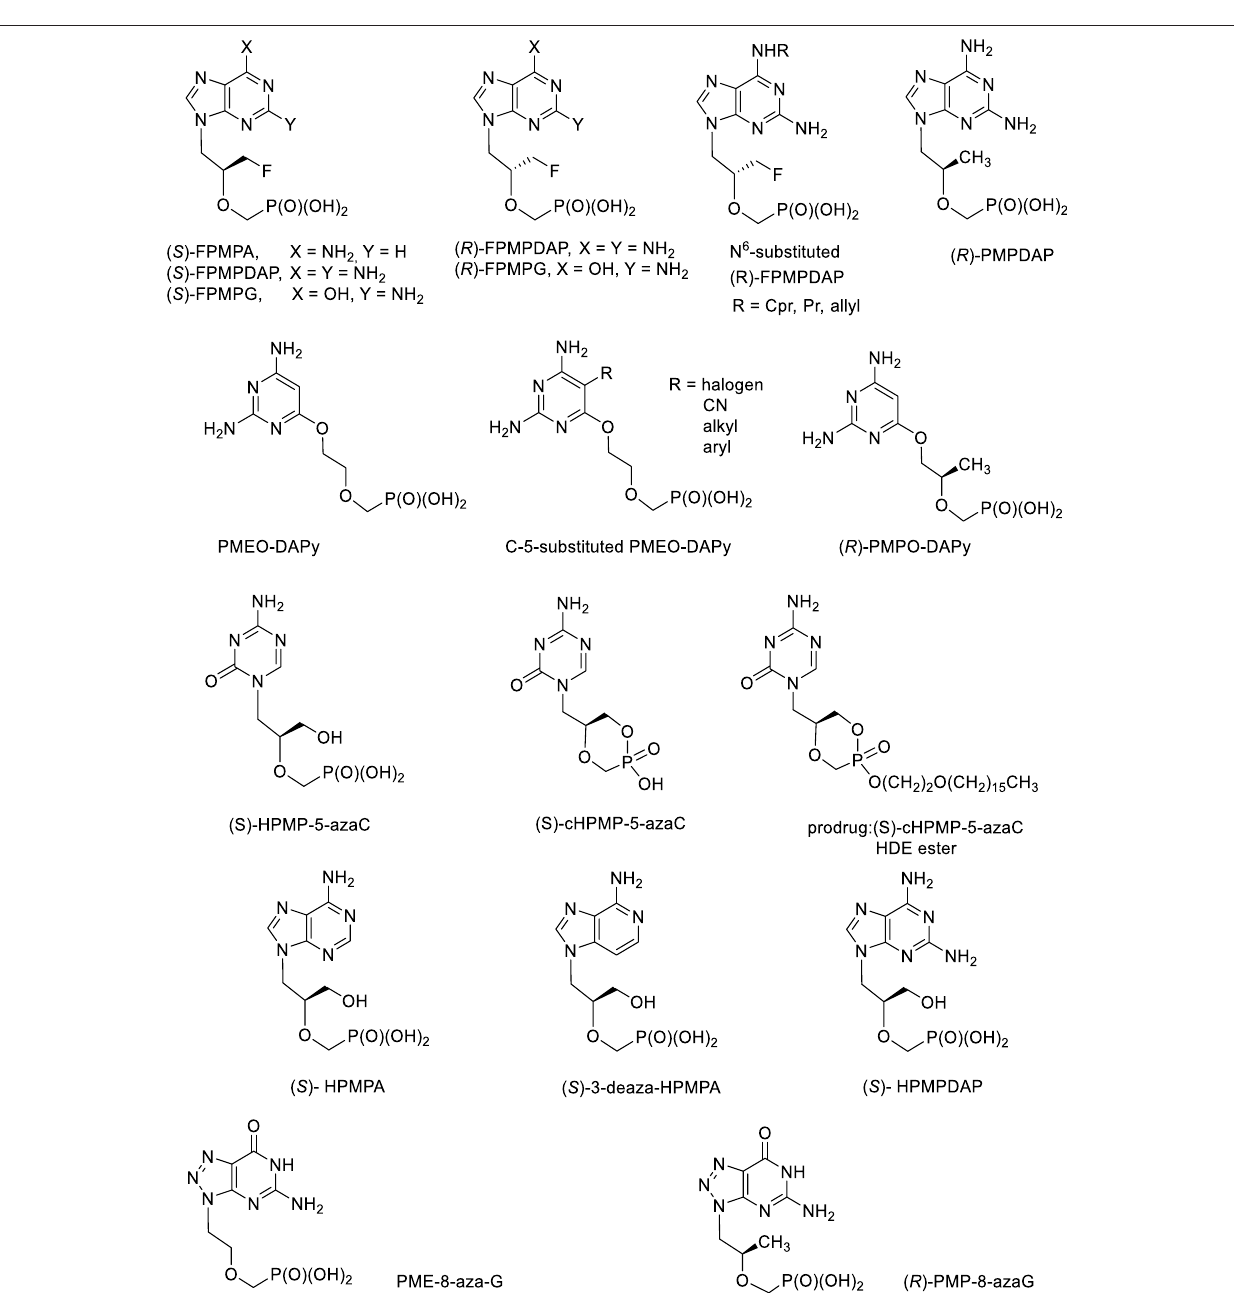
Frontiers in Chemistry |